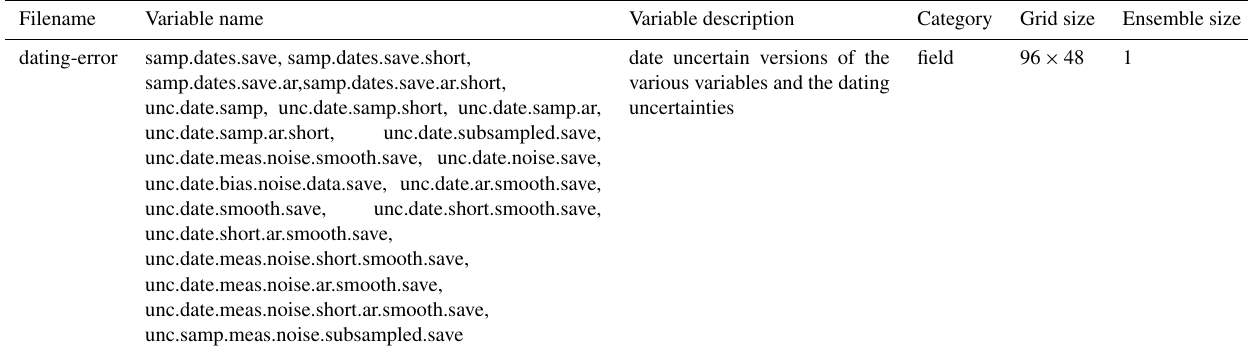
Table 3. Continued list of files provided, the variables included, their description, the category (full surrogate proxy field, essence field, or ensemble), and size of the ensemble. All files have the same stem Bothe_Trace21k_Pseudo_Proxies_ and the ending _annual.nc.